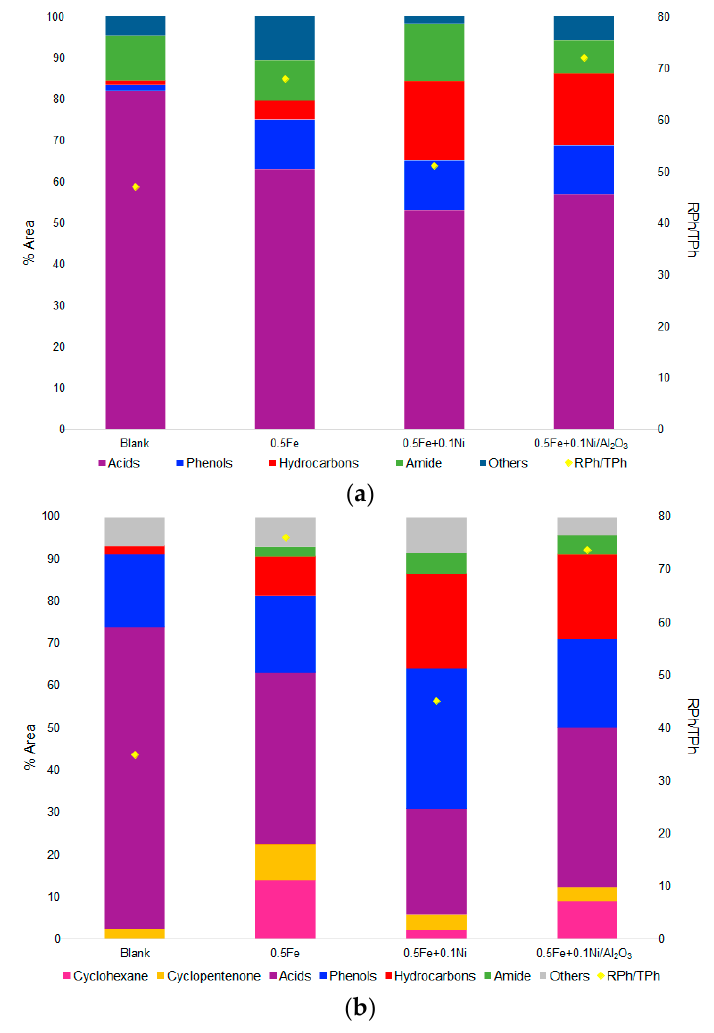
Figure 5. Compounds identified by GC-MS in the bio-crude at 330 °C, for a residence time of 10 min, for ( a ) BS and ( b ) BM. RPh/TPh: ratio of reductive phenols to the total phenols. Table 3. Composition (% area) of the hydrocarbons in the bio-crude obtained with 0.5Fe + 0.1Ni/Al 2 O 3 at 330 °C and for a residence time of 10 min.